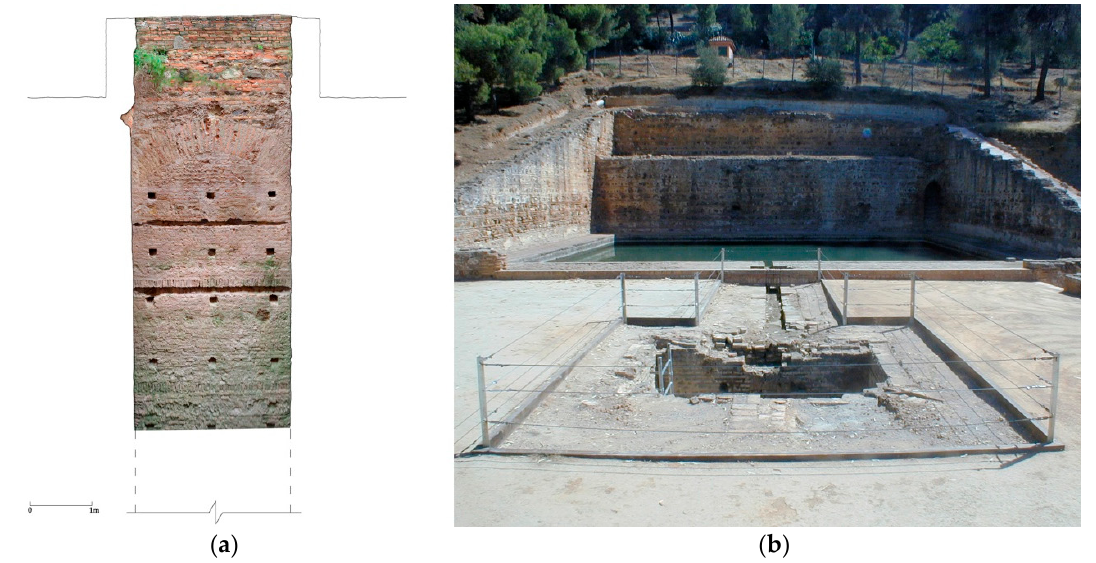
Figure 4. ( a ) Inside ortho-corrected photogrammetry of the Airon Well ( Alcazaba of Málaga); ( b ) Well connected to the Albercón de las Damas at the Generalife. Created by authors.